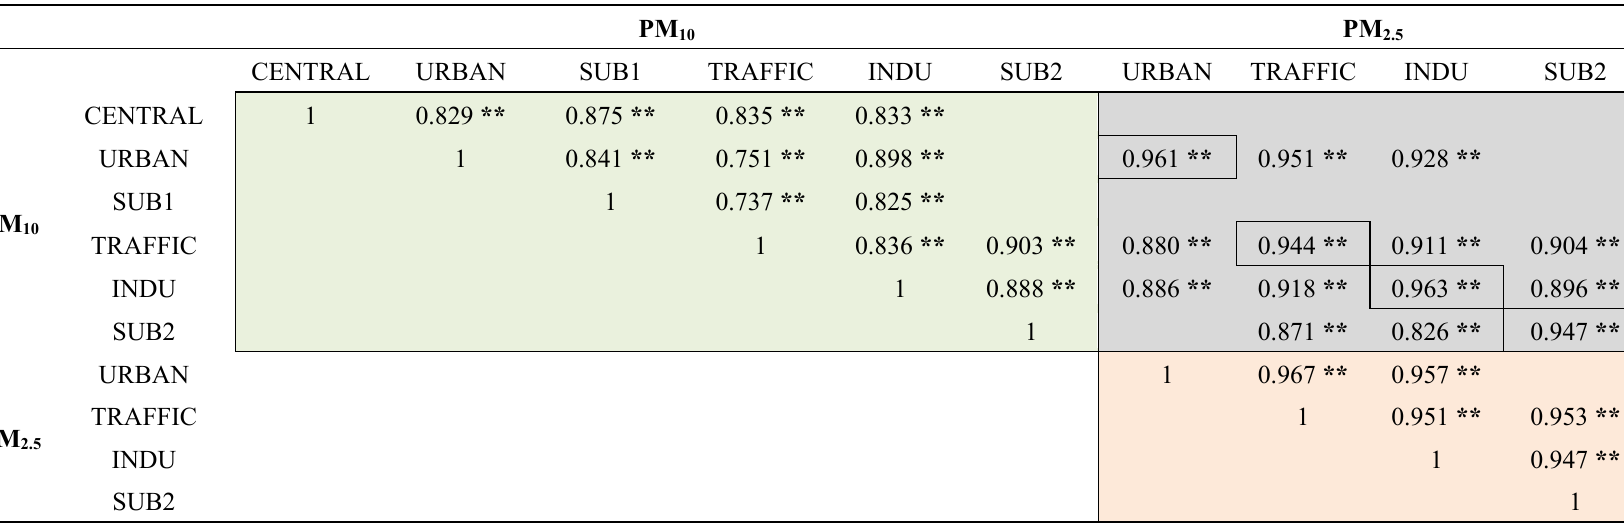
Table 2. Pearson’s correlation coefficients between PM 2.5 and PM 10 among the sites . ** denotes correlation coefficient which are significant at a <